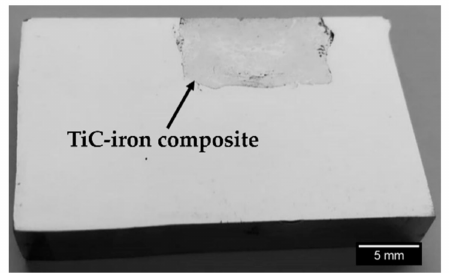
Figure 7. A polished cross-section of the reinforced specimen, showing the composite material.